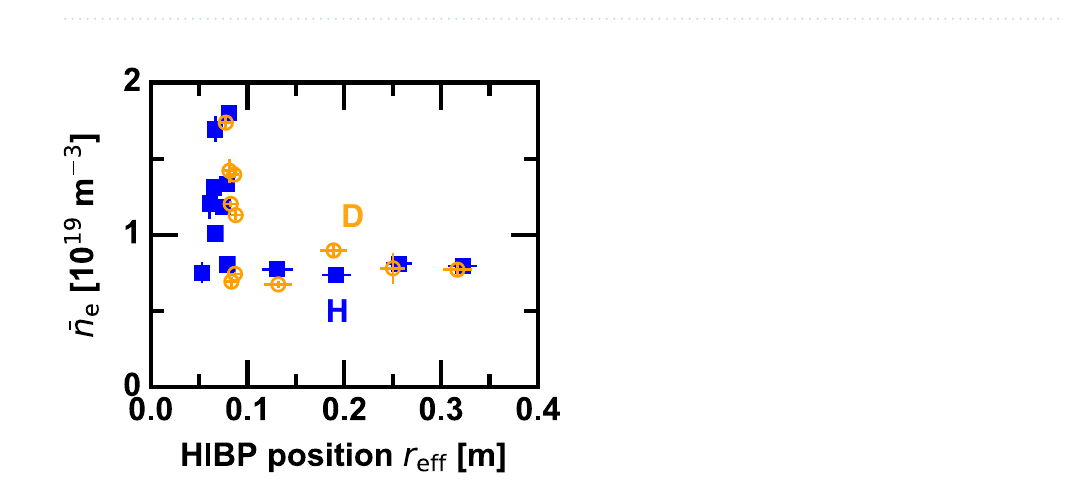
Figure 3. ( a ) Configuration of HIBP projected on the vertically-elongated poloidal cross-section; radial profiles of ( b ) the electrostatic potential and ( c ) the electron and ion temperatures; and (insert) schematic of the HIBP detector plates.